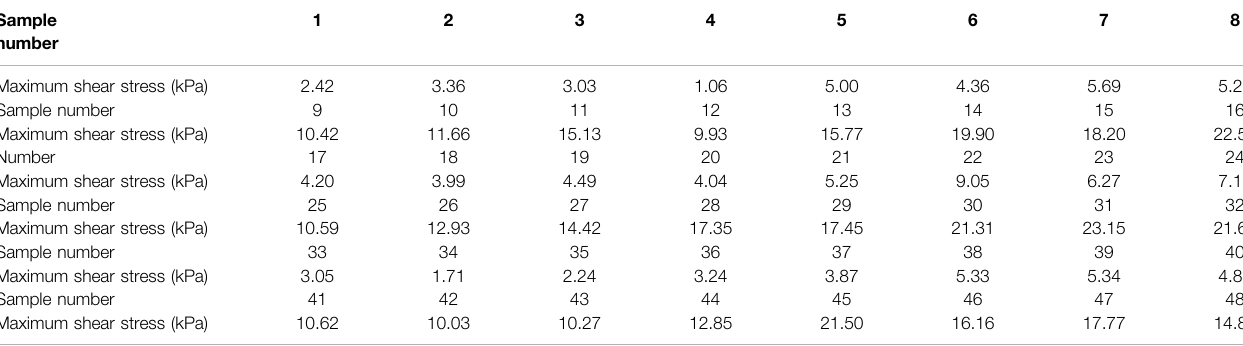
TABLE 4 | Maximum shear stress of MRF.